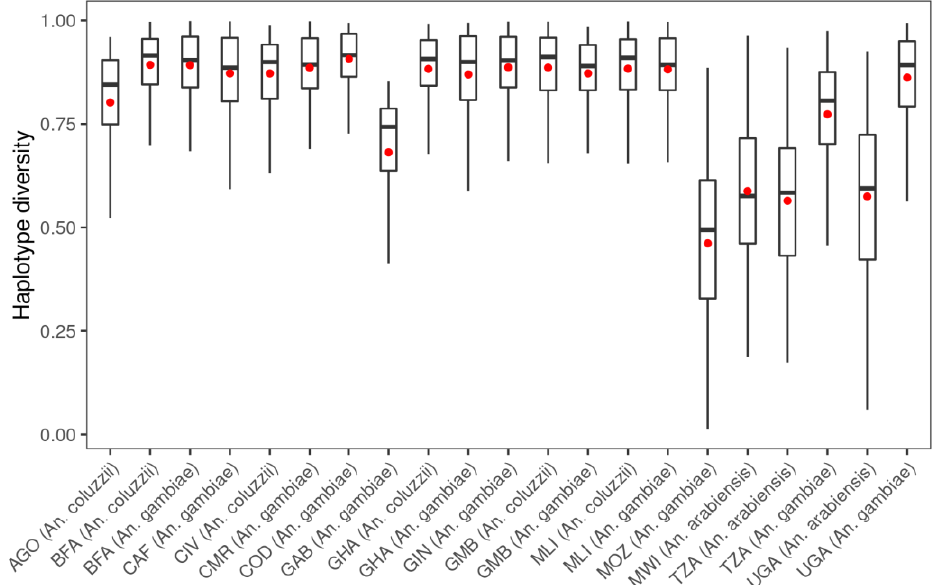
Figure A4. Haplotype diversity in a window of 500 bp across the genomic region of the Fruitless gene; red points indicate the mean of the haplotype diversity. AGO: Angola; BFA: Burkina Faso; CAF: Central African Republic; CIV: C ô te d’Ivoire; CMR: Cameroon; COD: Democratic Republic of Congo; GAB: Gabon; GHA: Ghana; GIN: Guinea; GMB: Gambia; MLI: Mali; MOZ: Mozambique; MWI: Malawi; TZA: Tanzania; UGA: Uganda.